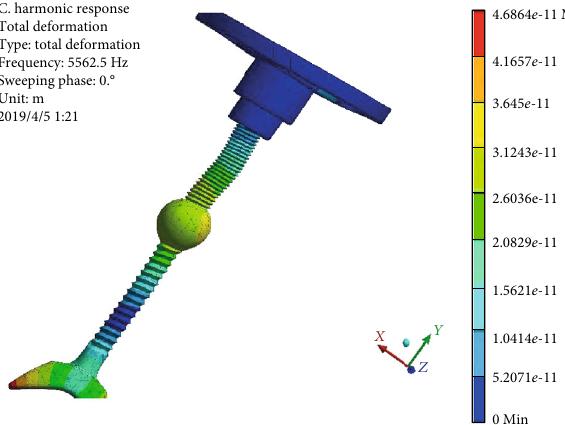
Figure 11: Displacement cloud of prosthesis pure titanium alloy.